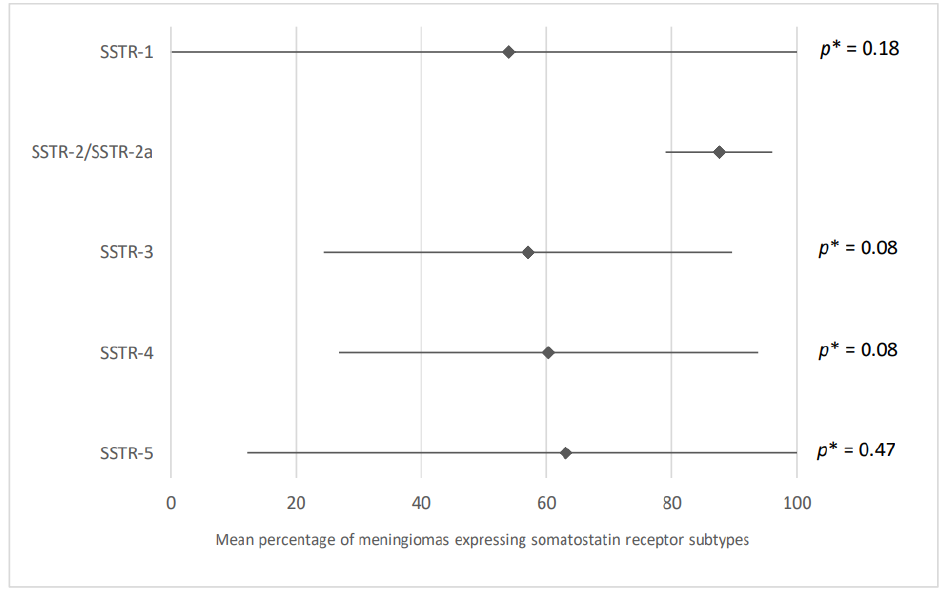
Figure 13. Expression of different somatostatin receptor subtypes in meningiomas. The results are expressed as a mean associated with their 95% confidence interval. SSTR: somatostatin receptor. p *: subtype SSTR-2/SSTR-2a versus other subtypes. Number of articles analyzed related to the topic for each respective subtype: 3, 8, 3, 3, 3. Number of included cases (total for all studies; minimum; max-